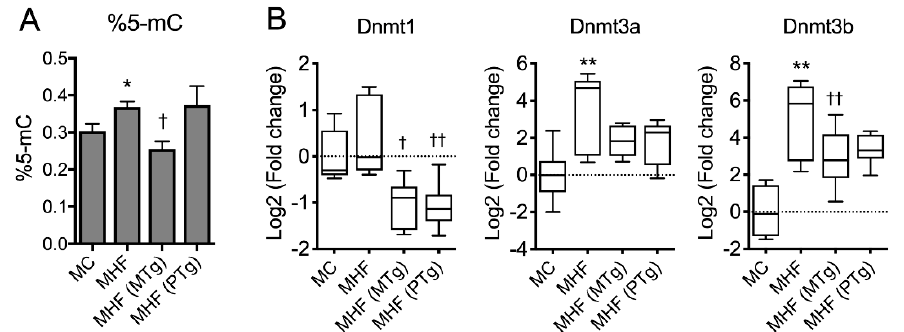
Figure 5. Parental SIRT1 overexpression suppressed global methylation in MHF offspring liver. ( A ) Global DNA methylation. ( B ) mRNA expression of DNA methyltransferases (DNMT). n = 4–6. vs. MC: * p < 0.05, ** p < 0.01; vs. MHF: † p < 0.05, †† p < 0.01.